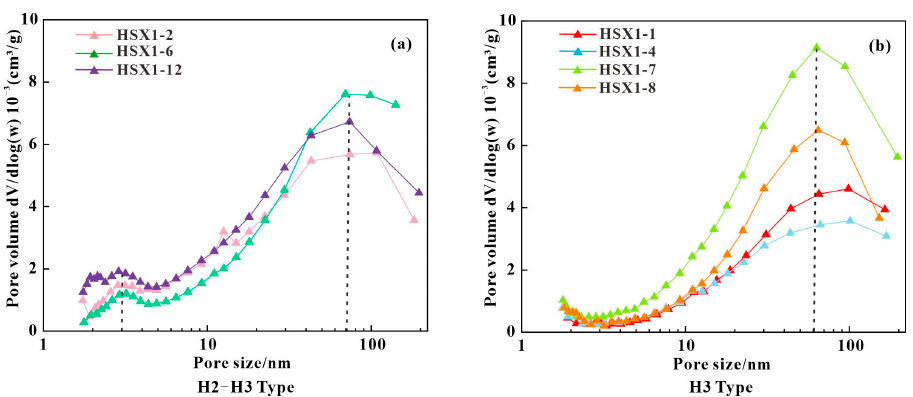
Figure 5. N 2 adsorption total pore volume and BET SSA of shales from Fengcheng Formation .